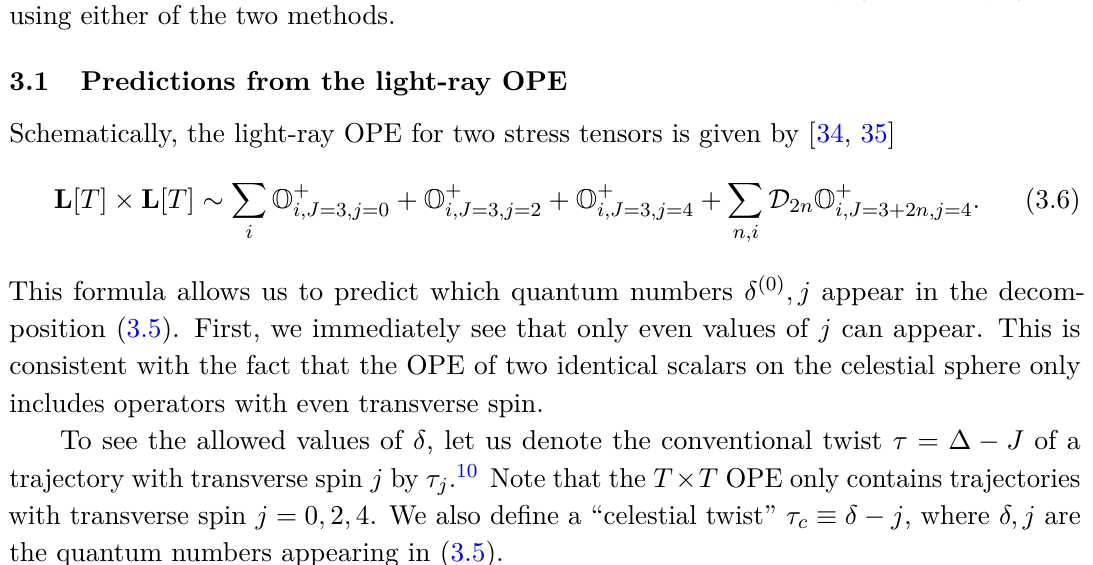
i and h R (0) γ (1) i δ,j ; δ 0 ∗ δ,j ; δ 0 ∗ δ,j i δ,j ; δ 0 ∗ γ (1) i coefficient of the orange line can be obtained using δ,j ; δ 0 ∗ δ,j